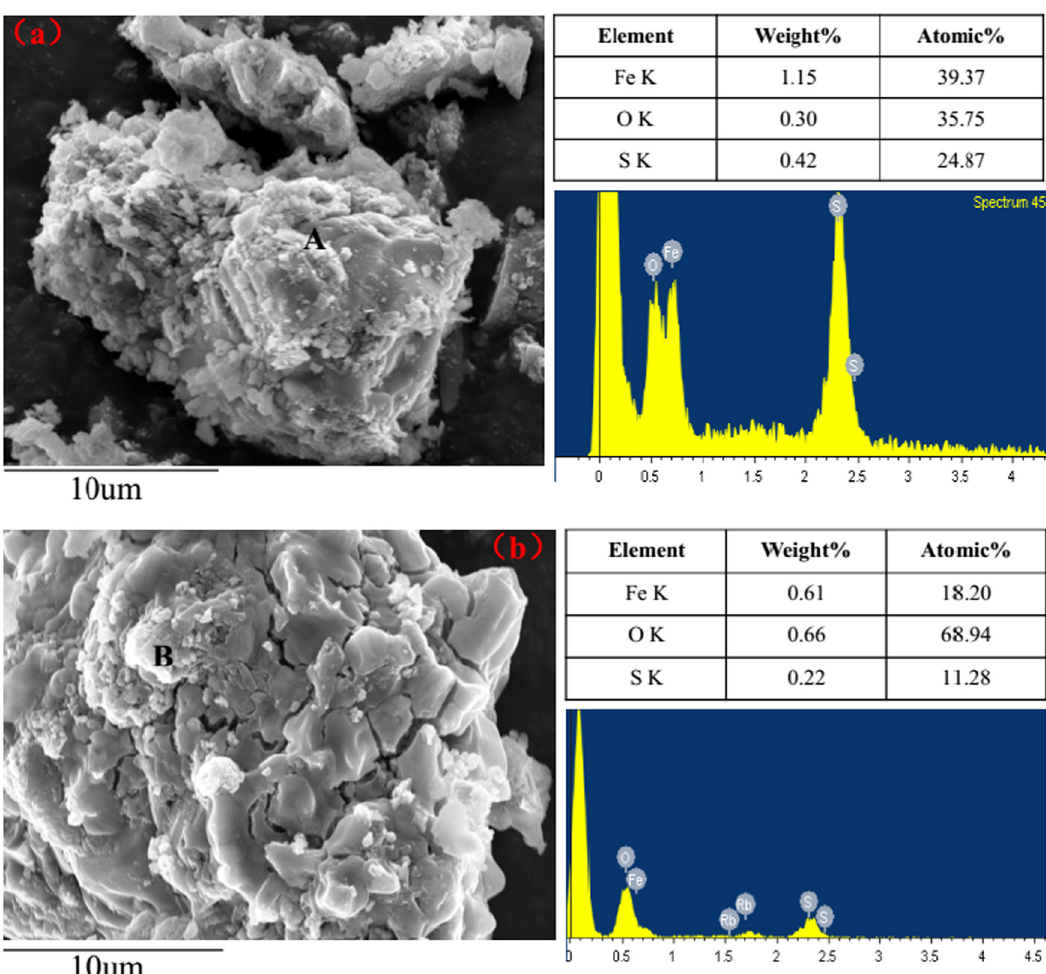
Figure 9: The SEM images and energy spectrum of A/B area in copper ore tailings and roasted slag. ( a ) Copper ore tailings; ( b ) roasted slag at 1,000°C for 30 min, air fl ow 5 L min − 1 .